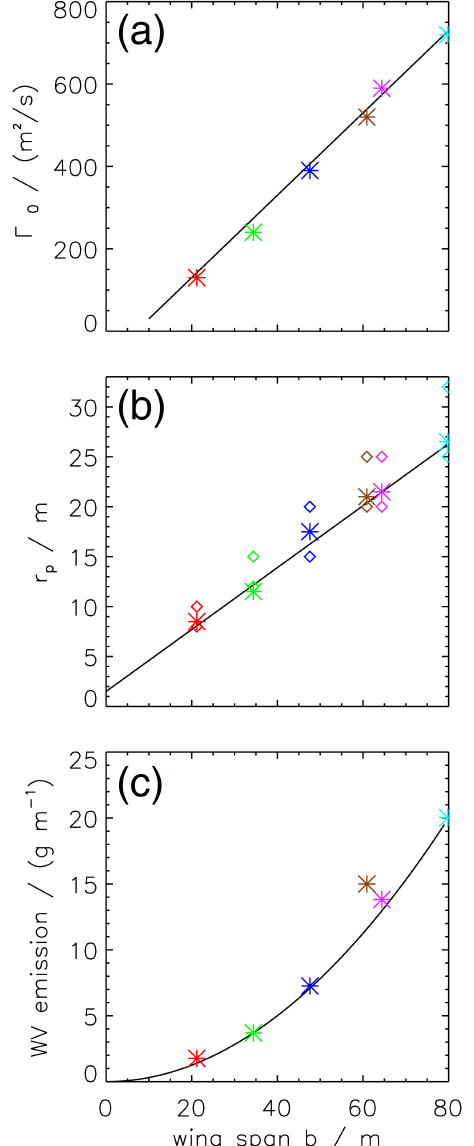
Figure A1. Top: relationship between the initial wake vortex cir- culation (cid:48) 0 and wing span b for medium aircraft mass as as- sumed in UG2014. The straight line shows the simple approxima- tion (cid:48) 0 = ( − 70m + 10 b) ms − 1 . Middle: relationship between the (intermediate) plume radius r p and b . The straight line shows the simple approximation 1 . 5m + 0 . 314 b . The diamonds show two sets of initial plume radii as used in UG2014. Bottom: relationship be- tween water vapour emission V and b for medium fuel flow at cruise conditions as assumed in UG2014. The parabola shows the simple approximation 20gm − 1 (b/ 80m ) 2